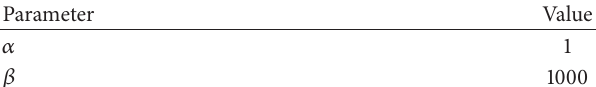
Figure 12: Single sine input test. Table 2: Nominal CNF